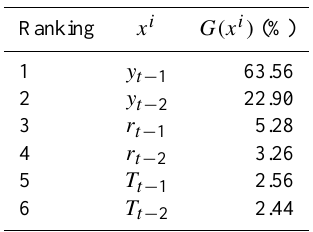
Table 5. Input ranking results for the Canning River dataset (aver- age over 10 data groups). The initial variance is